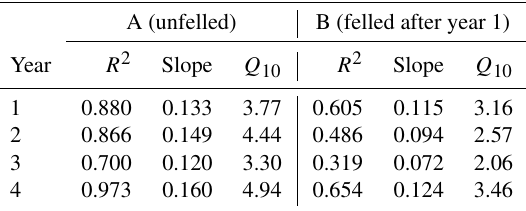
Table 3. Annual apparent Q 10 values for soil CO 2 effluxes in area A (mature spruce stand, remaining) and area B (mature spruce stand, clear-felled after year 1) in Harwood Forest during the study period (as defined in Table S1 in the Supplement).